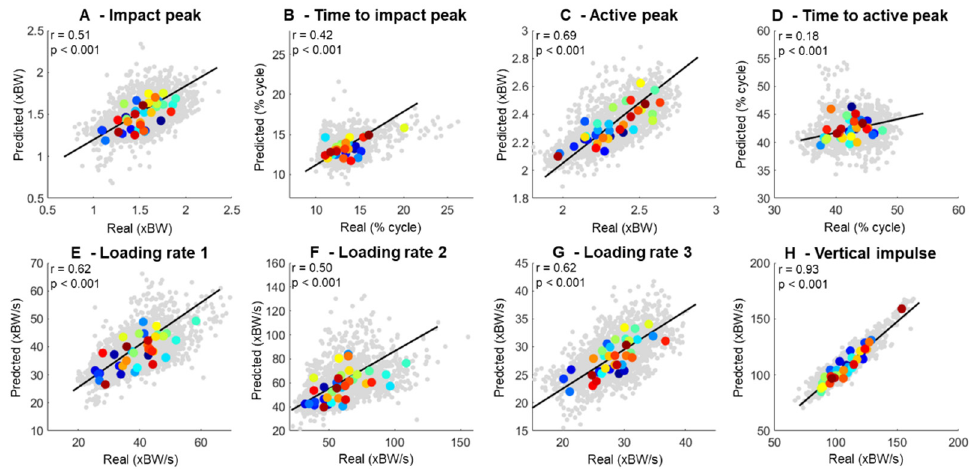
Figure 6. Association between running biomechanical variables extracted from 1716 running trials ( gray points in the background ) using real vs. predicted vertical ground reaction forces. Each participant’s average across all trials (N = 37) is represented as the same large colored dot across all subplots.